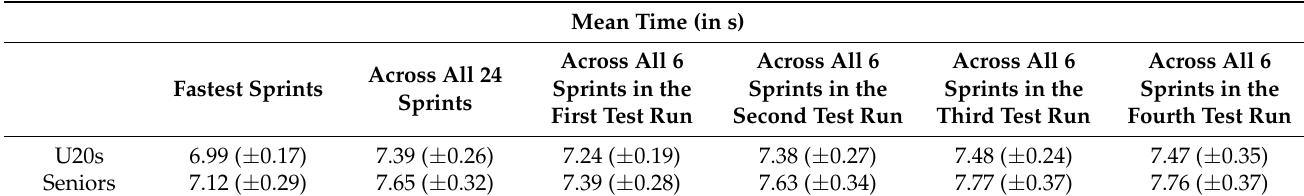
Table 1. Mean fastest sprint times and mean sprint times (and standard deviations) across all 24 sprints and across all sprints during each of the four test runs [in s] as a function of age (U20 and senior handball players).